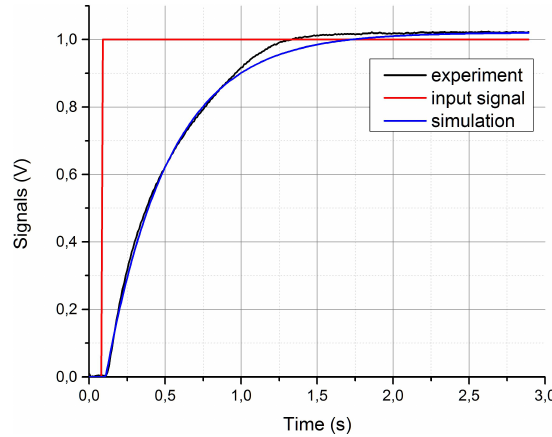
Figure 7: Step response of the open system.